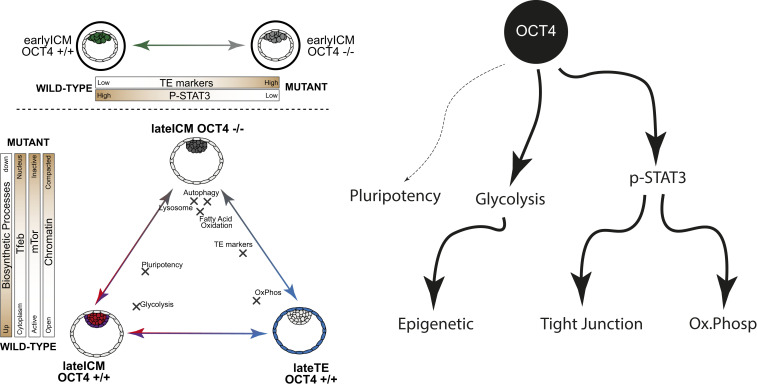
Scheme of OCT4 function in preimplantation embryo development.